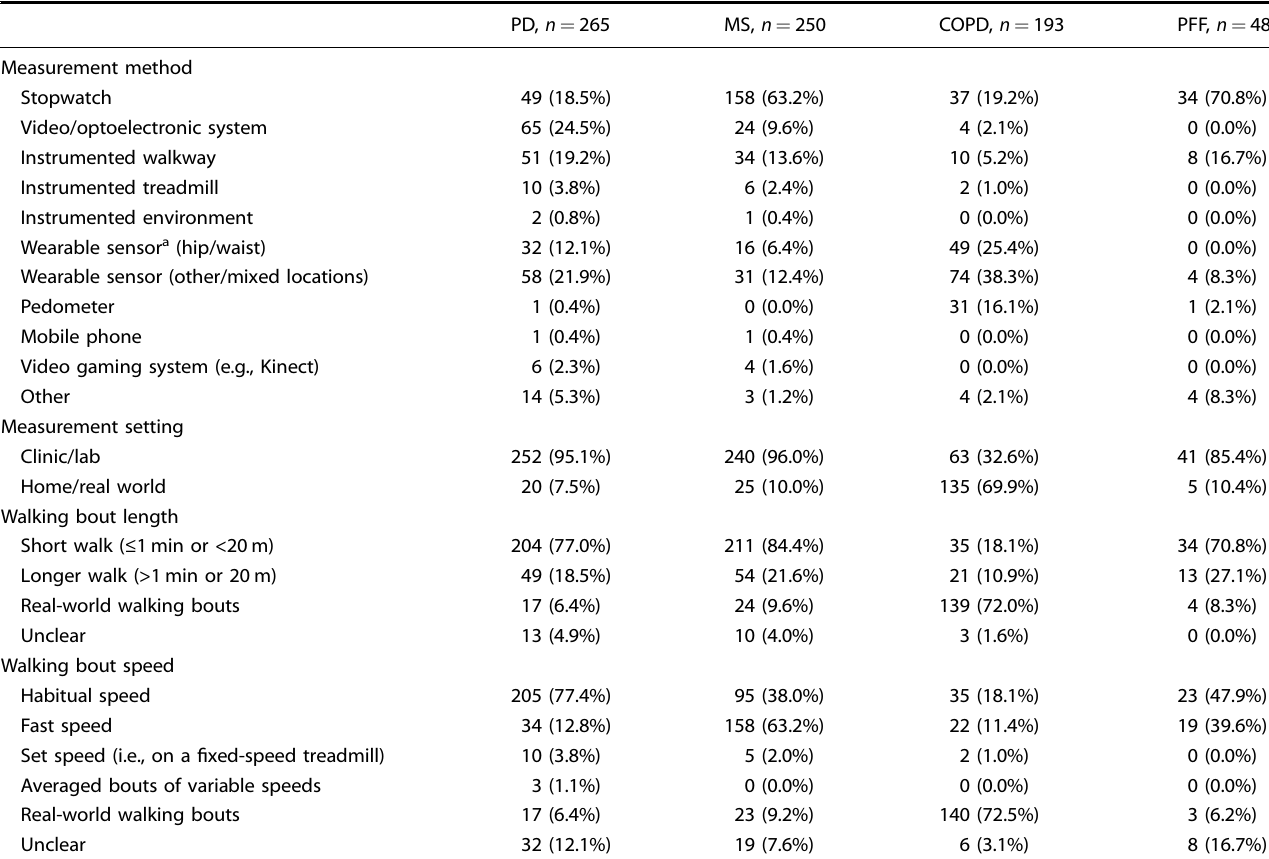
Table 1. Walking conditions and measurement methods used in included